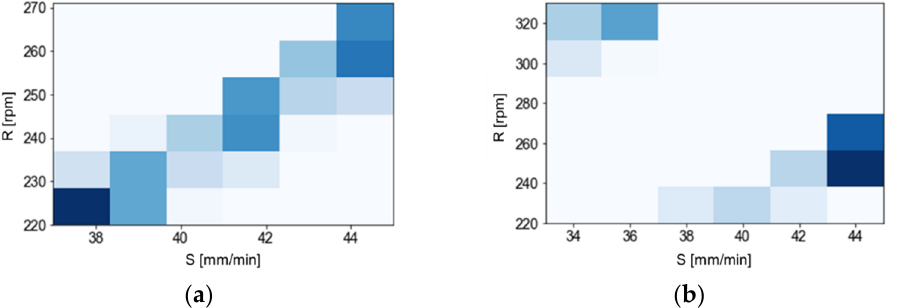
Figure 11. Histogram of ( a ) the most common sets of parameters for the best 5% of the CMV results and the W_ALL weight set and of ( b ) the best 5% of the CMV results and the TH weight set (the darker the colour, the higher the frequency of occurrences).